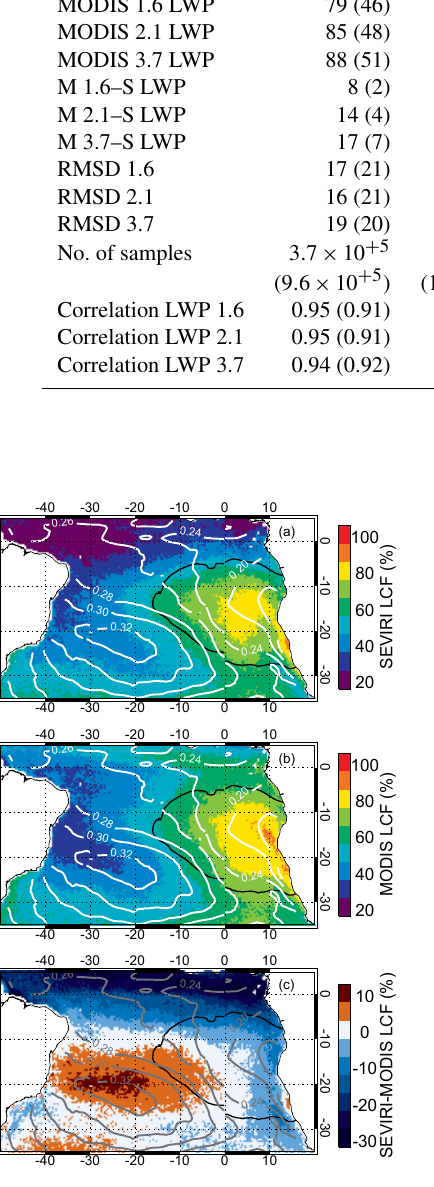
Figure 7. The 2-year-mean map of liquid fraction of cloud amount of (a) SEVIRI, (b) MODIS, and (c) SEVIRI–MODIS bias for the all-sky case. Contours represent the heterogeneity measure H σ computed from 3km resolution SEVIRI 0.63µm reflectances.